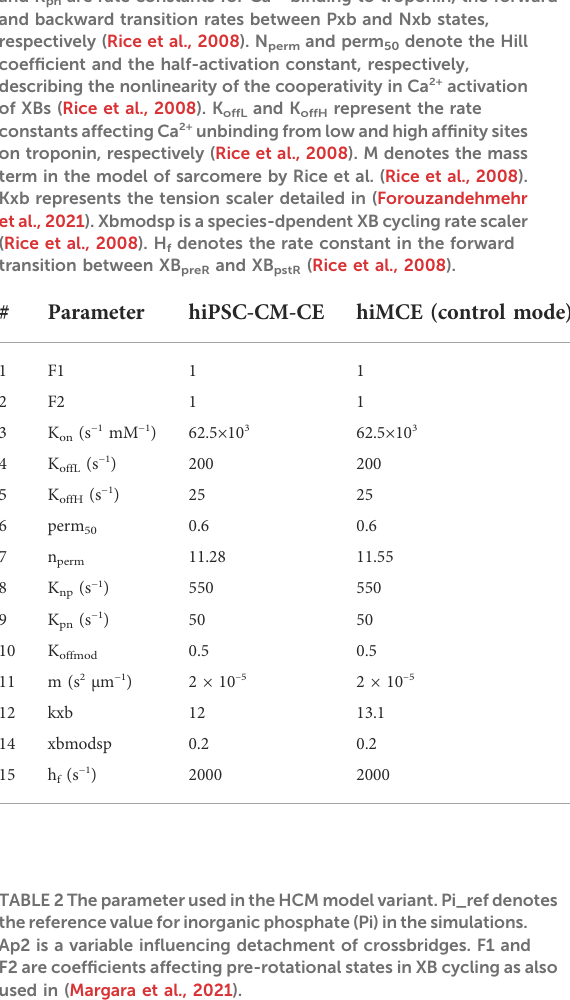
TABLE 1 The values of the contractile element parameters for hiPSC- CM-CE (Forouzandehmehr et al., 2021) and hiMCE. F1 and F2representDRX:SRX/(DRX:SRX) control ratiointheXBcycling.K on ,K np and K pn are rate constants for Ca 2+ binding to troponin, the forward